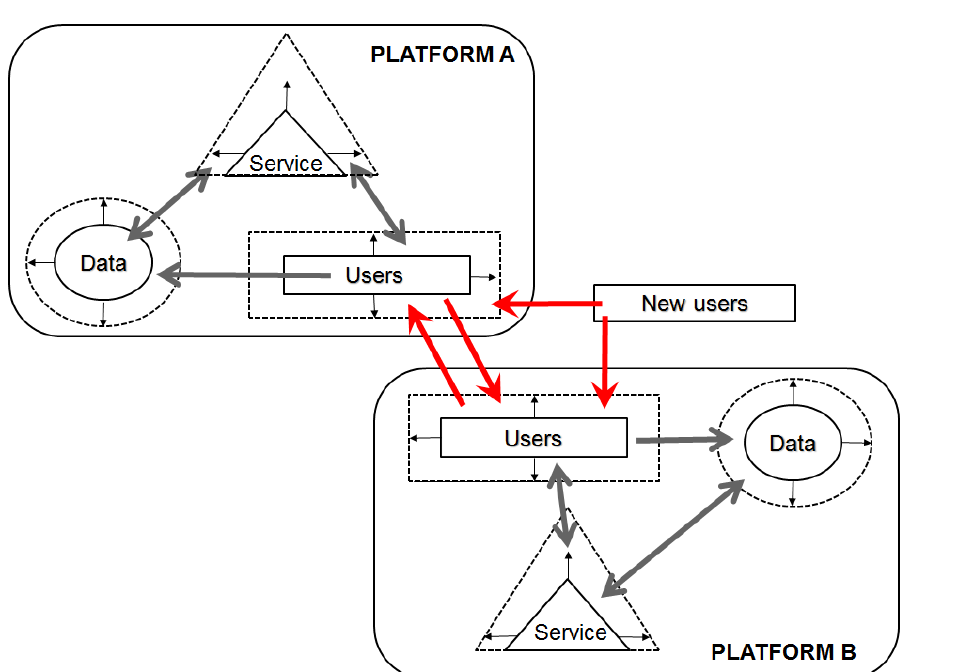
Figure 2: The Platform-Data Model for Complements. Solid lines show the initial situation. Dashed lines indicate the situation after platform B has gained market share. Thick arrows show dependencies. Qualitative